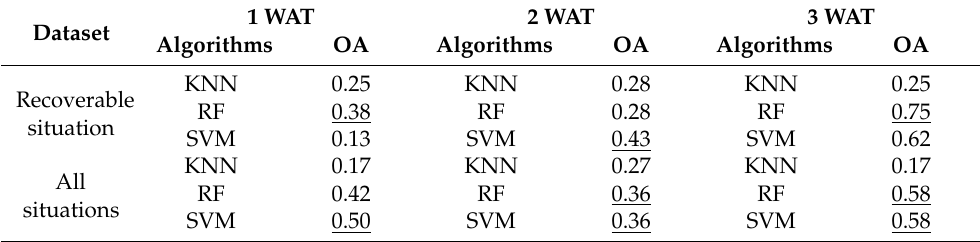
Table 3. Accuracy in determining the severity of the herbicide damage based on spectral features and machine learning